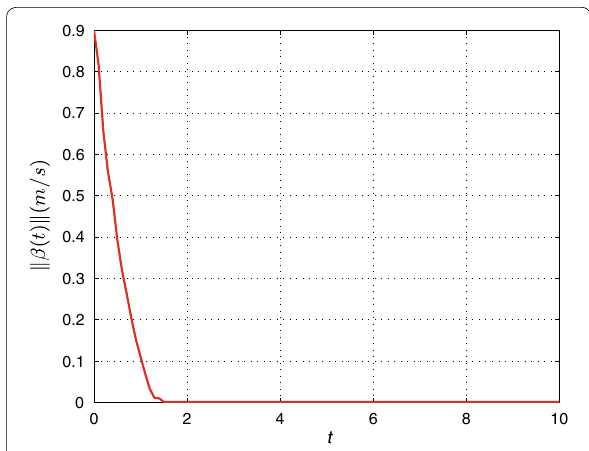
Figure 10 Histories of error of constraint